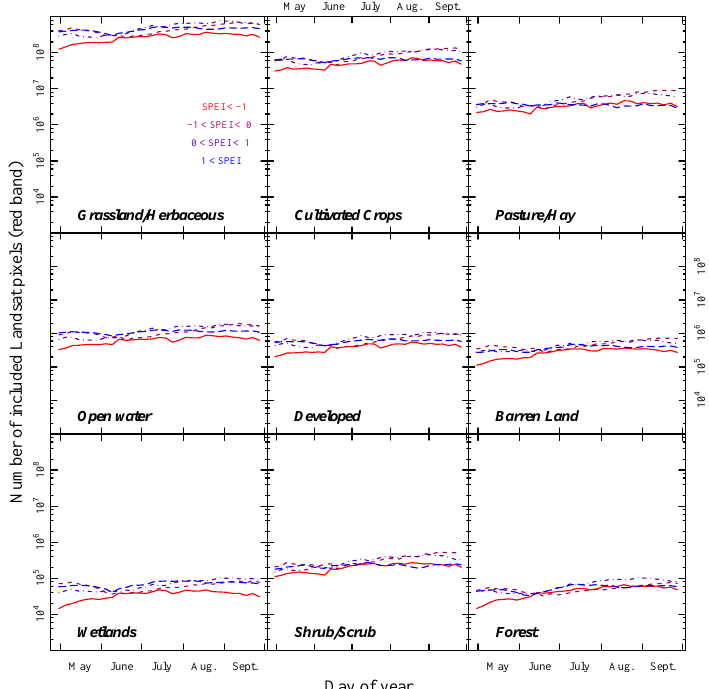
Figure A4. Number of Landsat pixel measurements included in the figure showing average red reflectance by day of year, drought intensity, and land use/land cover (LULC). Each point on the lines shows the number of Landsat red reflectance measurements for all pixels in the study area/period that are within a 40 day window of the day of year, the specified SPEI range, and the specified LULC category. The solid red line is the driest category (SPEI < − 1), the short dashed maroon line drier than average (SPEI between − 1 and zero), dashed dotted indigo line wetter than average (SPEI between zero and one), and dashed blue line the wettest (SPEI > 1 )